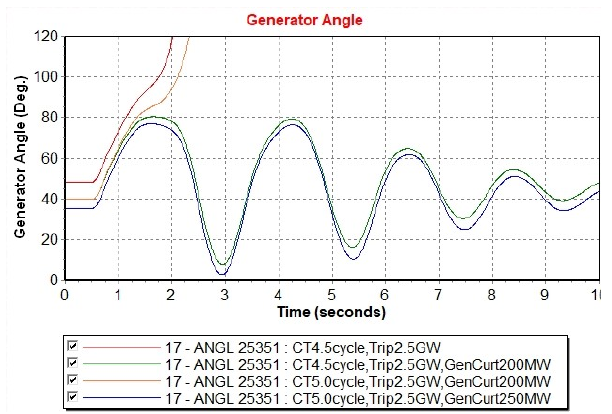
Figure 8. Examination of transient stability with different control measures.